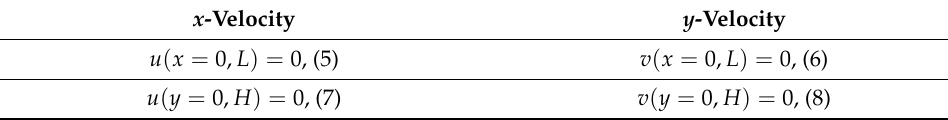
Table 2. Non-slip boundary conditions of fluid on walls [4].